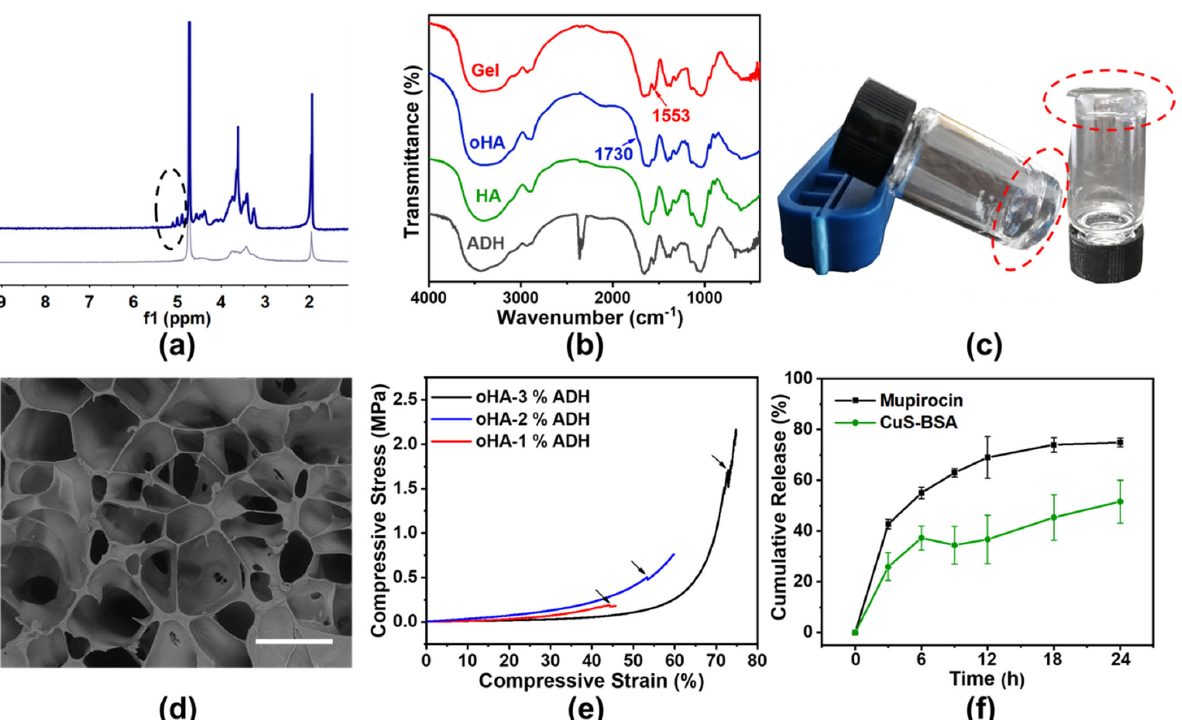
Figure 3. Characterizations of oHA and Gel. ( a ) 1 H–NMR spectra of oHA and HA. ( b ) FT–IR spectroscopy of Gel, oHA, ADH, and HA. ( c ) Optical image and ( d ) SEM image of Gel after complete gelation. Scale bar: 100 μ m. ( e ) Mechanical properties of Gel with different ADH concentrations (1%, 2%, 3%). ( f ) Release behaviors of M@Gel with mupirocin concentration of 1.0 mg/mL and C@Gel with Cu concentration of 24 ppm.